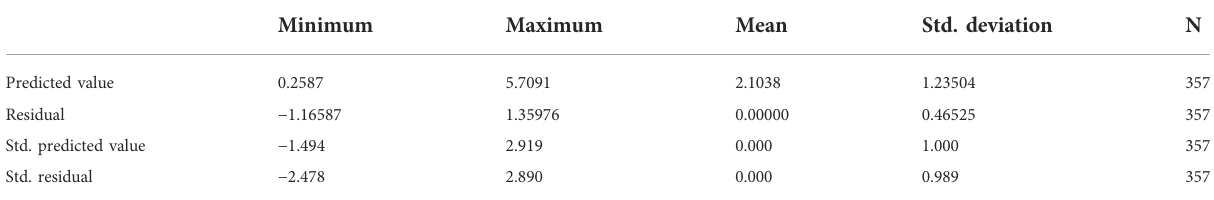
TABLE 7 Regression ’ s residual statistics for GC-1 in the energy